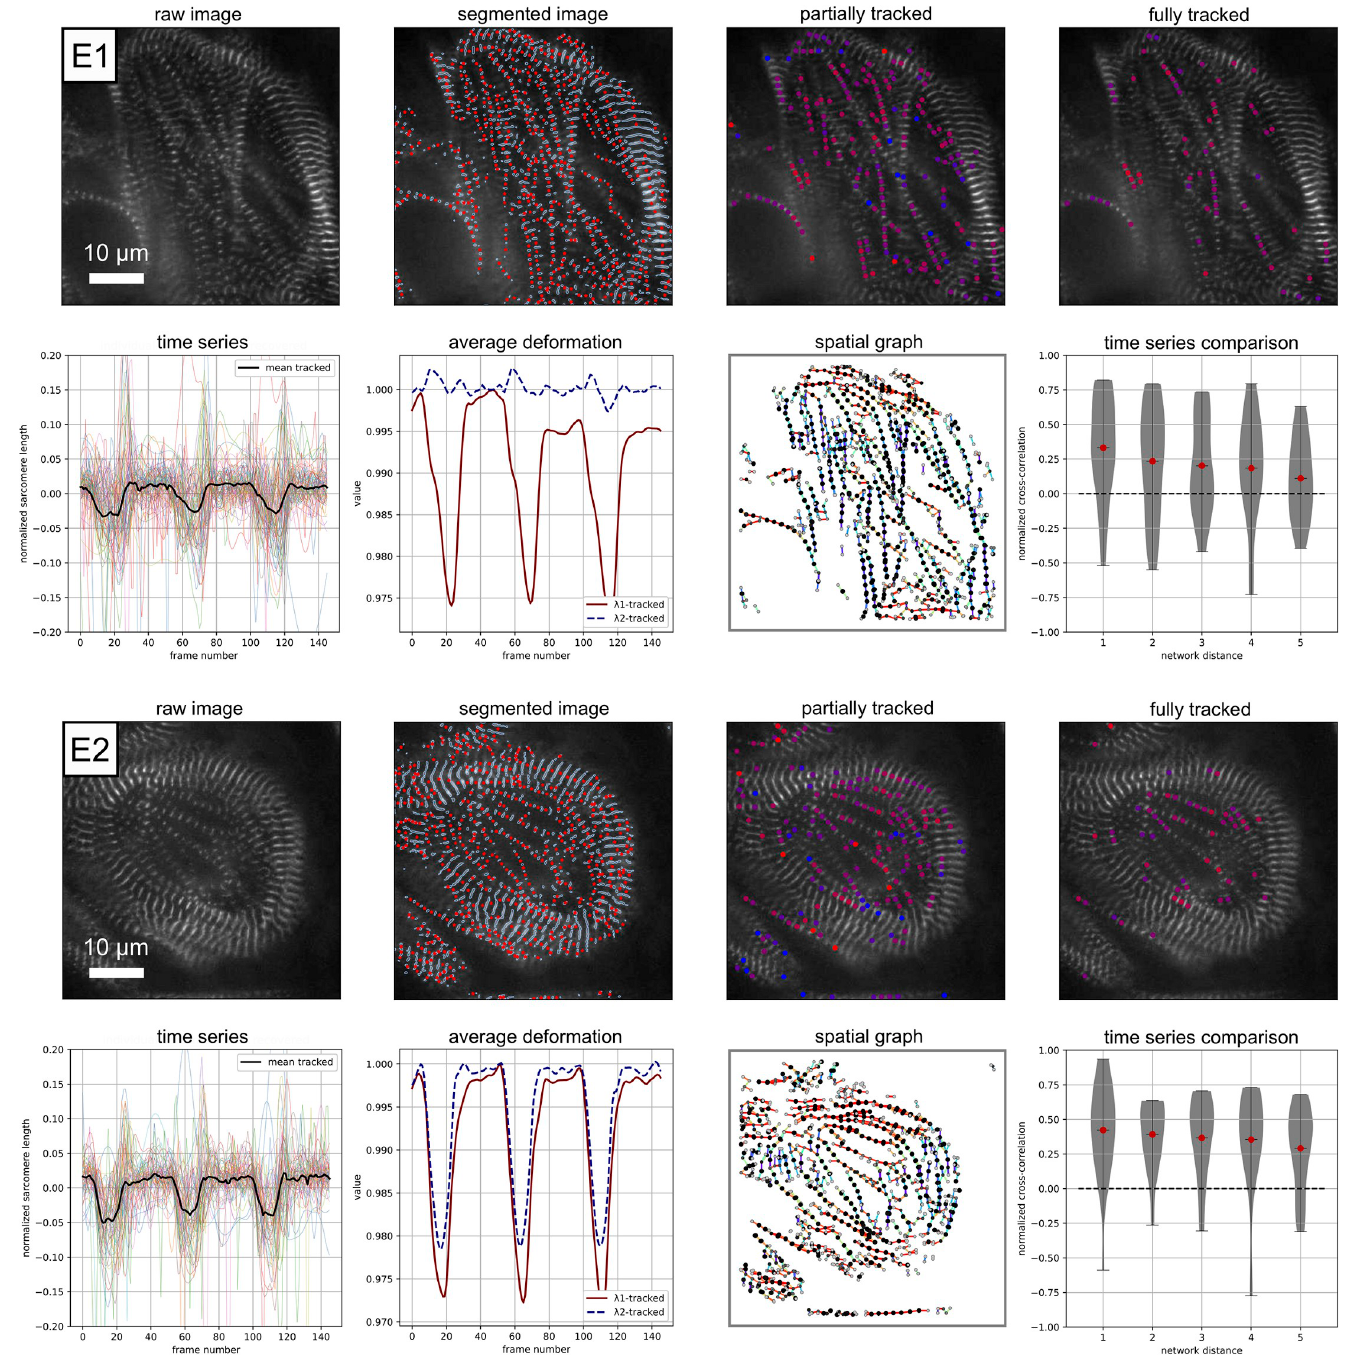
Fig 7. Example performance on experimental data E1 and E2: Raw image visualization; z-disc and sarcomere segmentation; Sarcomeres that are tracked for 1/3 or more of the movie, red corresponds to a contracted state, blue corresponds to a relaxed state (frame 20); Sarcomeres that are tracked for 3/4 or more of the movie, red corresponds to a contracted state, blue corresponds to a relaxed state (frame 20), note that these sarcomeres are included in the time series analysis; Individual time series data for normalized sarcomere length; Average deformation behavior; Illustration of the data represented as a spatial graph, color corresponds to sarcomere orientation; Normalized sarcomere time series cross-correlation score plotted as a function of the distance along the network. S1 and S2 Movies are included for further visualization.